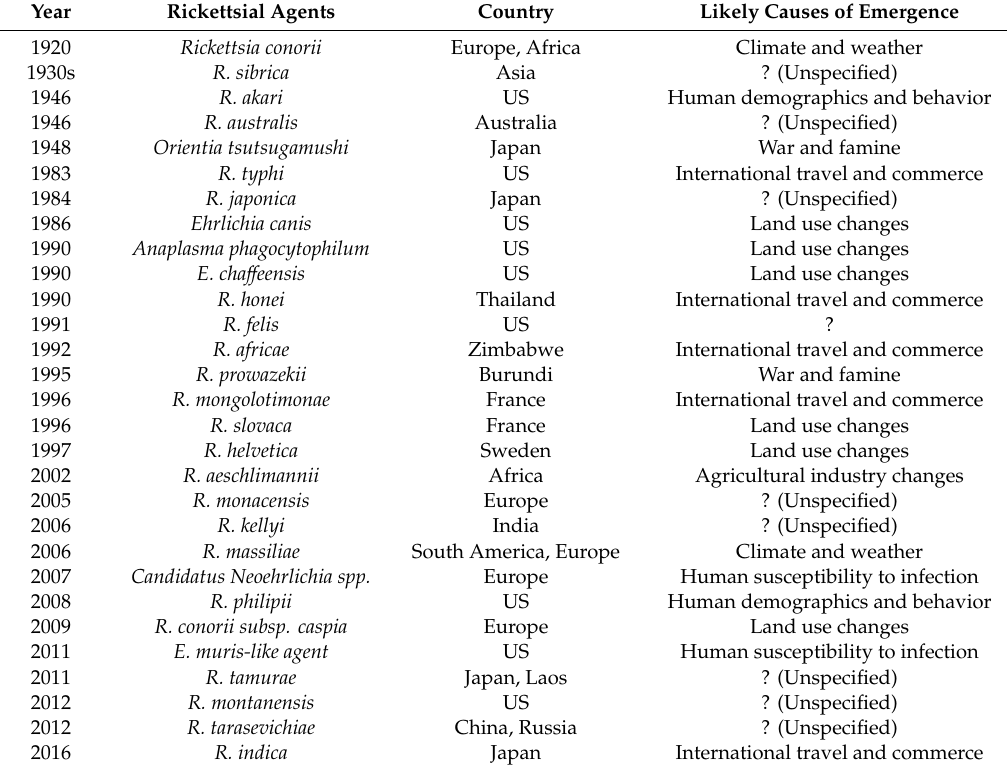
Table 1. Emerging rickettsioses (from the supplementary materials of Jones et al. [18] and Swei et al. [19]) from 1920 to 2016 (with the exception of novel rickettsial